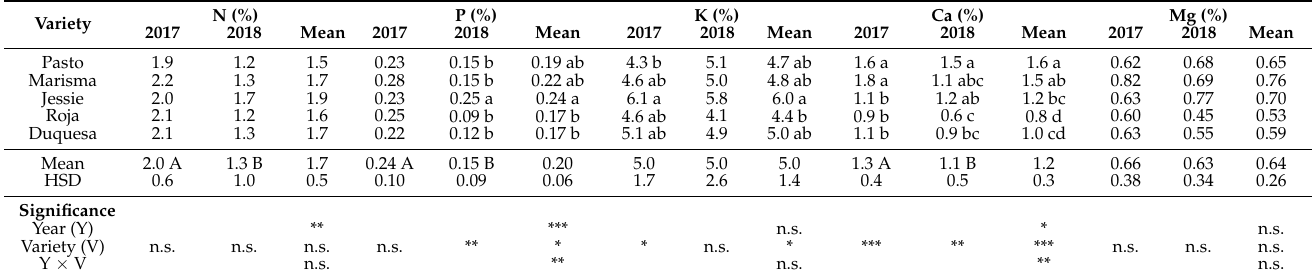
Table 3. Mineral composition of straw of five quinoa varieties during the two years (2017 and 2018) of field experiments. Variety